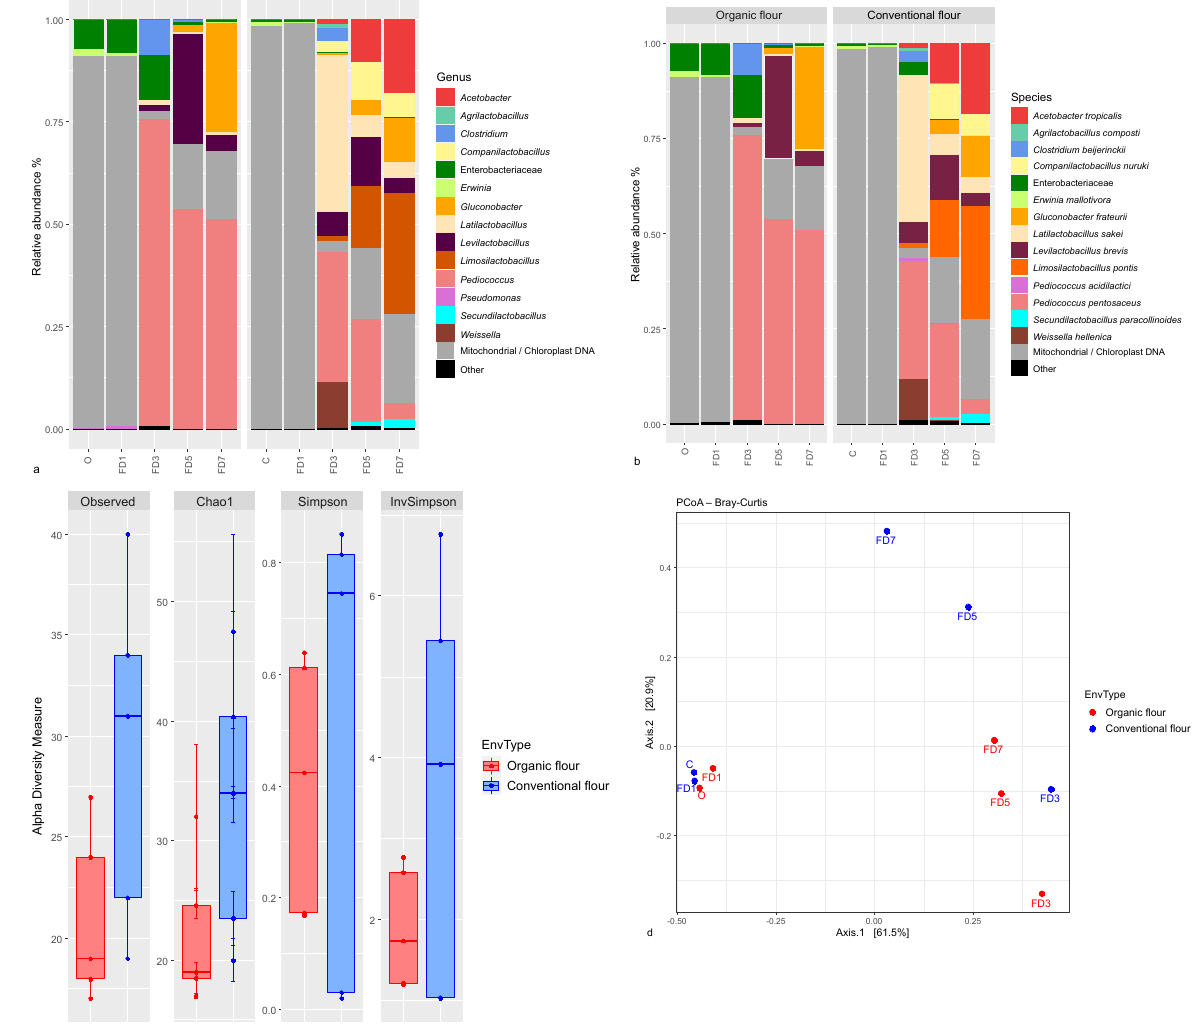
Figure 2. Bacterial genus (a), species (b), alpha-diversity (c) and beta-diversity for PCoA (d) based on Bray-Curtis evaluation for organic and conventional flours and sourdough samples during leavening. O: organic whole wheat flour; C: conventional whole wheat flour; FD1 (0 h), FD3 (120 h), FD5 (168 h), and FD7 (216